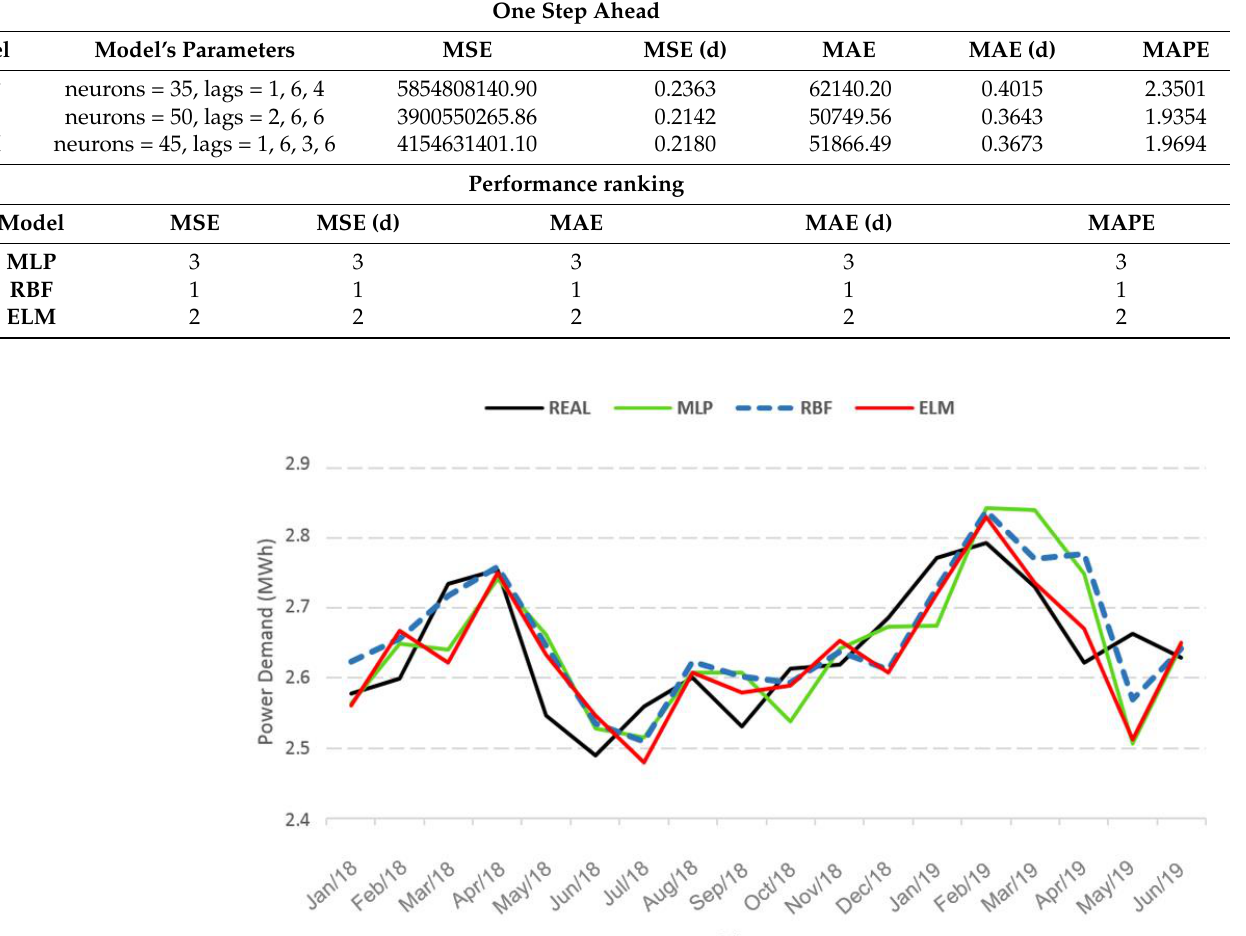
Table 17. Forecast results for one step ahead, compared by the error measures MSE, MAE, MAPE, and their respective performance rankings.